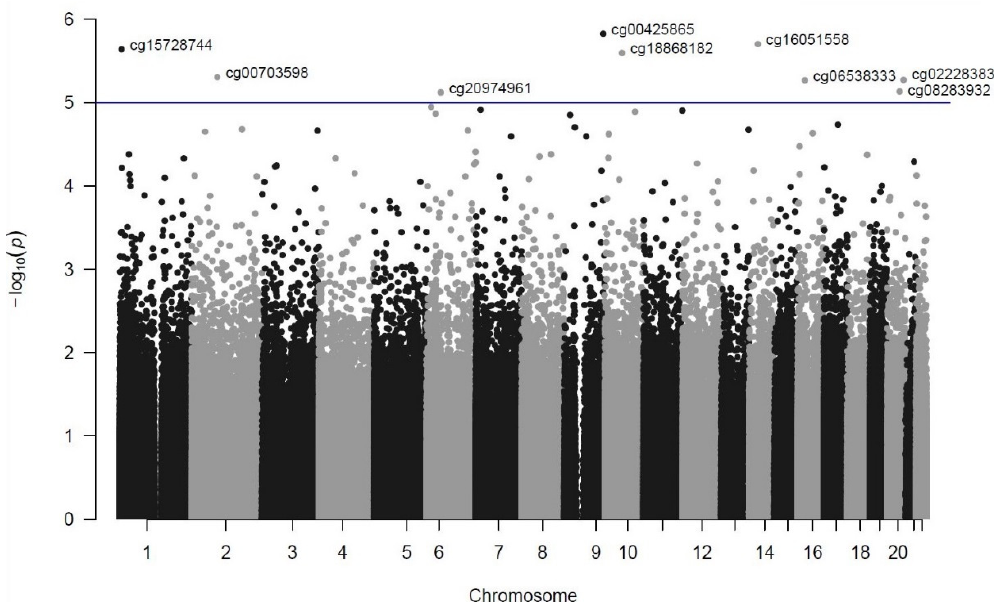
Figure 2. The Manhattan plot shows the p -value and chromosomal position of all CpG sites investigated. Each dot represents a CpG site, and the horizontal blue line denotes the threshold ( p = 1 × 10 − 5 ) for suggestive significance. Sites with suggestive significance are annotated with Illumina CpG loci ID. Negative logarithm base 10 ( − log 10 ) of the p value is shown on the y -axis and chromosome positions on the x -axis. Table 2. Enrichment of gene ontologies and pathways among DMPs with p <